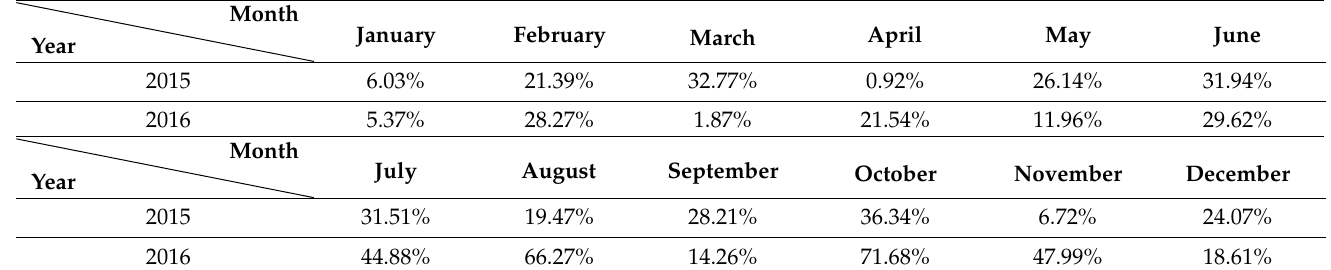
Table 7. The accuracy of the drought classification model in 12 months (Grassland Region of Aus- tralia